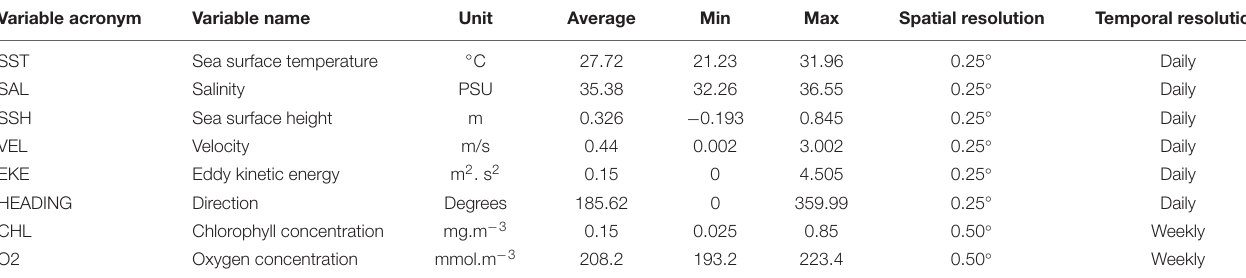
TABLE 1 | Predictor variables used for modeling tuna and non-tuna occurrence with DFAD data in the Indian Ocean. Variable